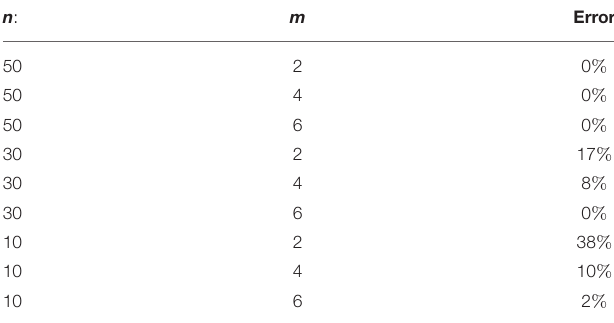
values were m =2, ǫ 0 = 1, q =0.9, λ ( thr )